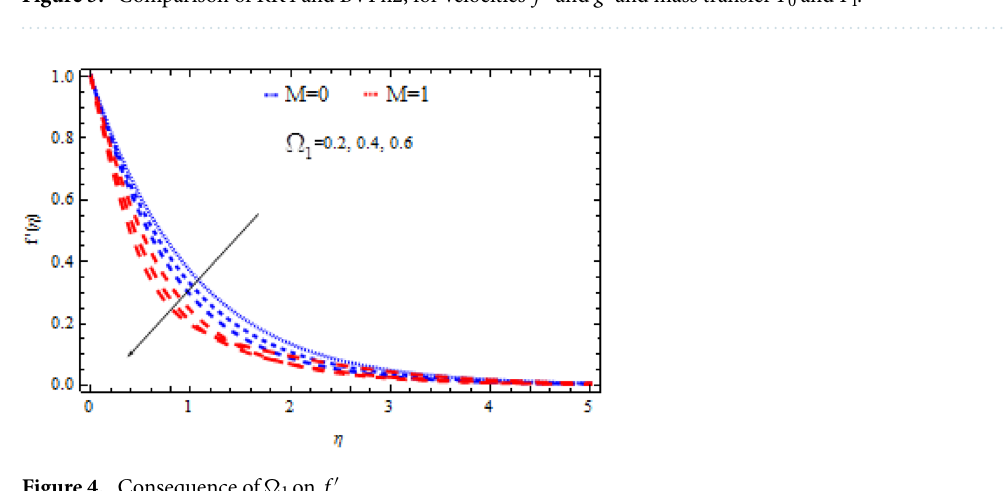
Figure 3. Comparison of RK4 and BVPh2, for velocities f ′ and g ′ and mass transfer T 0 and T 1 .